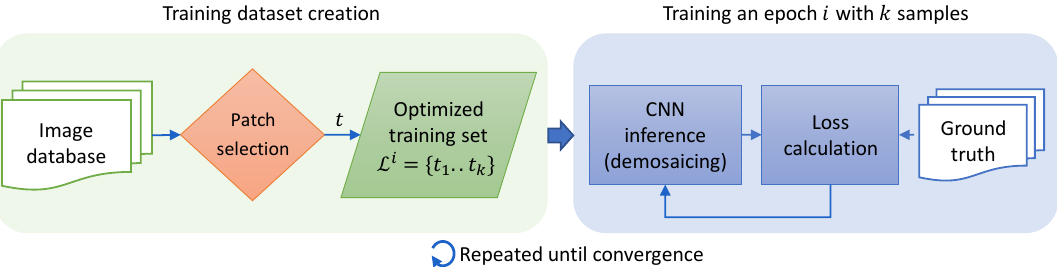
Figure 1. Block diagram of the training pipeline for a single epoch, from an input image database to loss calculation and back-propagation. The proposed data selection techniques apply to the orange diamond shape in the block